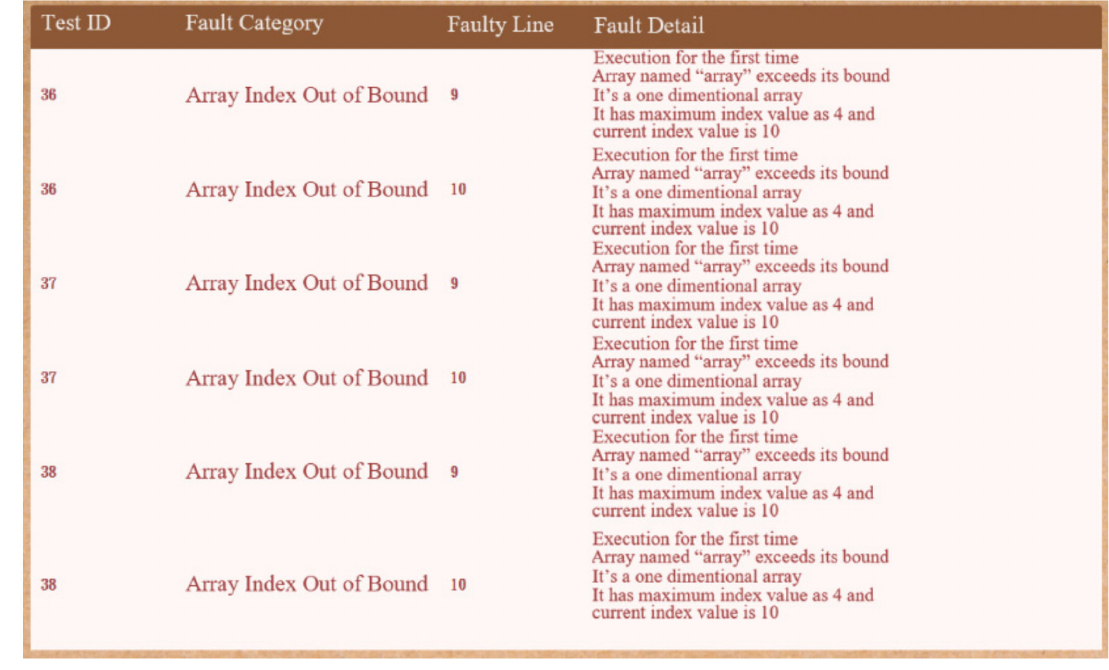
Figure 6. Feedback of array index out of